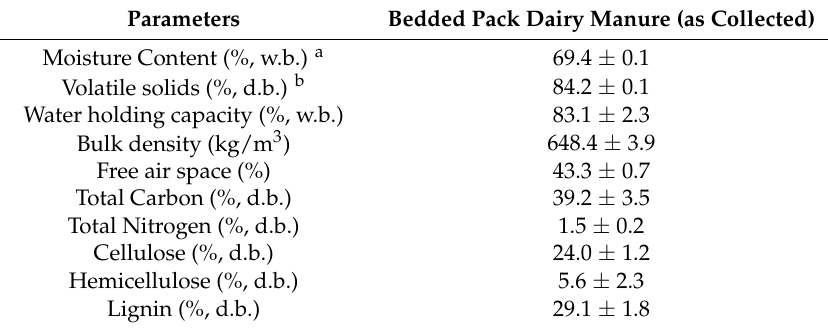
Table 1. Characteristics of dairy manure from a sawdust-bedded pack barn. Data represent means ±